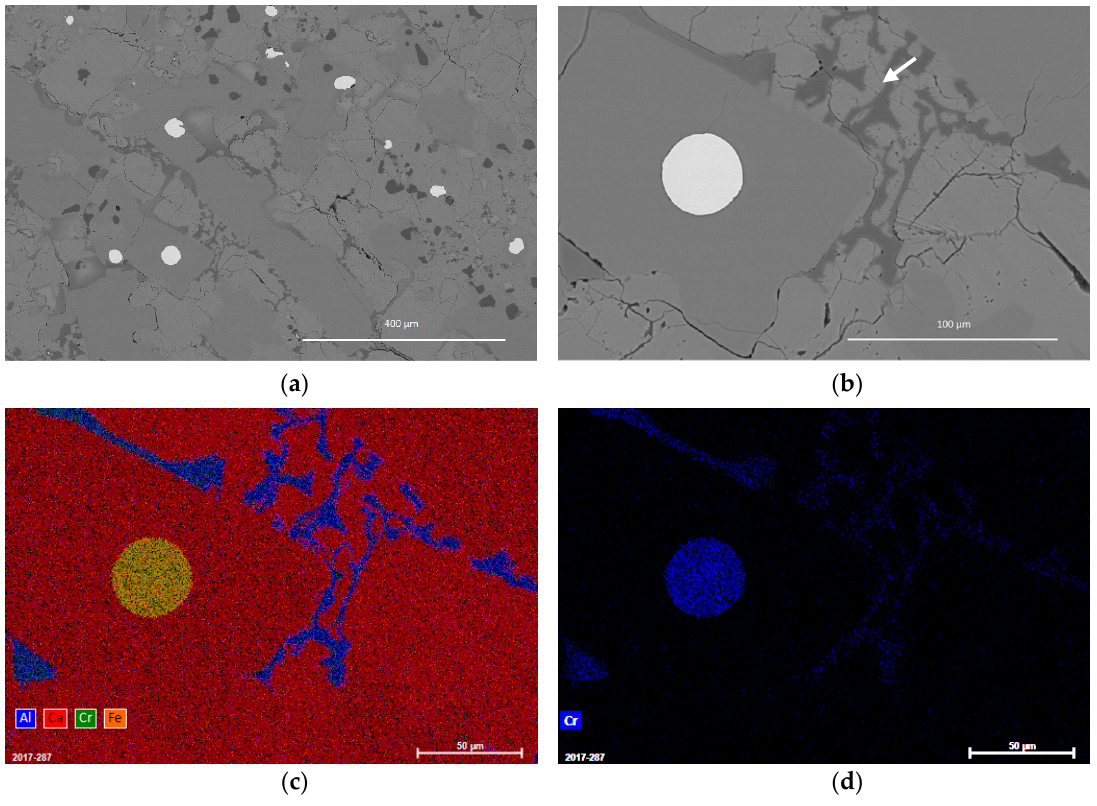
Figure 3. ( a ) SEM-BSE image of LC FeCr slags showing FeCr metal (white particles) in a matrix of elongated CaMg silicates with veins of spinels. ( b ) Detailed view of CaMg silicate with embedded FeCr particles surrounded by a spinel (arrow). ( c ) Main element distribution map determined by EDX. ( d ) Cr distribution as measured by EDX, showing Cr in FeCr particles and spinels.